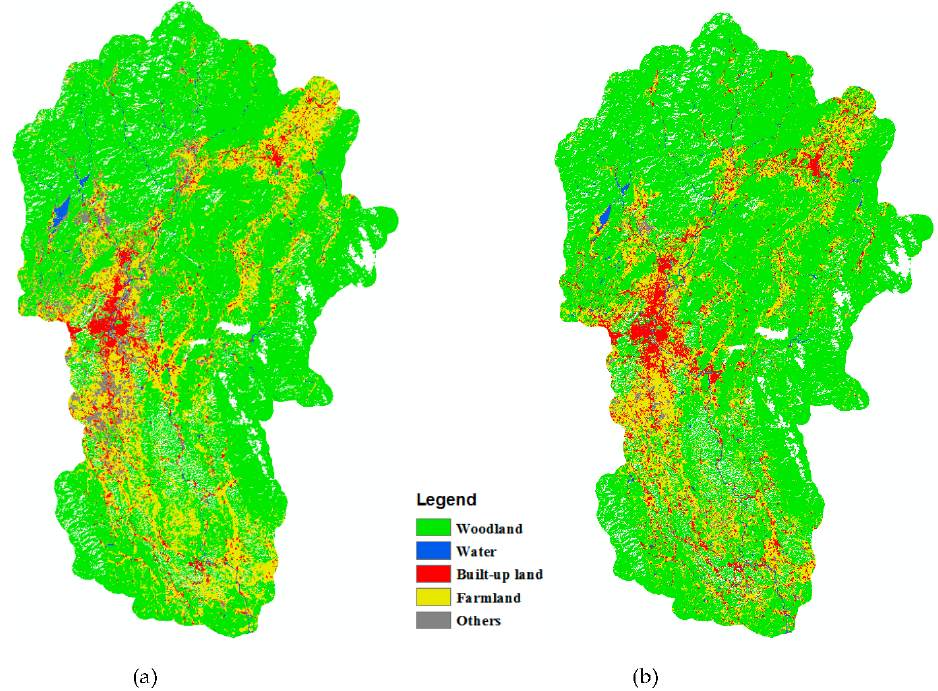
Figure 5. Land use/cover in Lijiang River Basin: ( a ) 2009; ( b ) 2013.